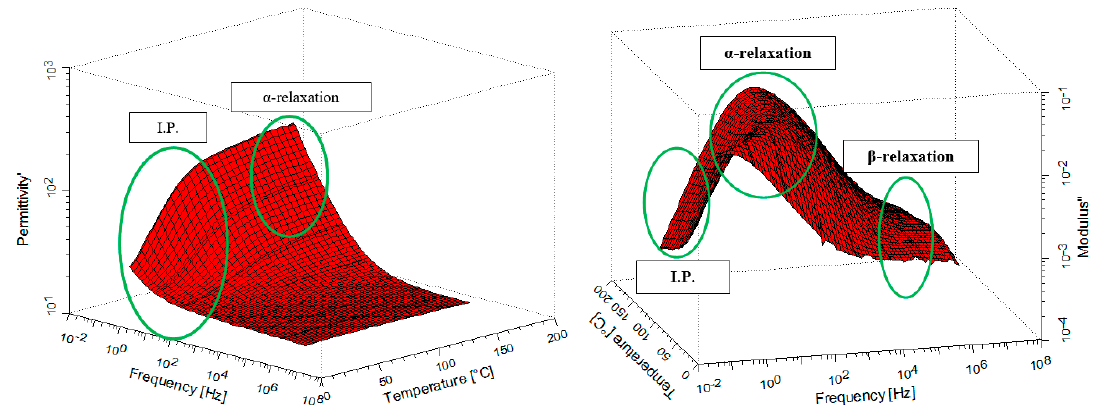
Figure 9. The real part of the dielectric permittivity ( left ) and the imaginary part of the electric modulus ( right ), versus frequency and temperature, for the 10% w/w BaTiO 3 –NV nano- composites.